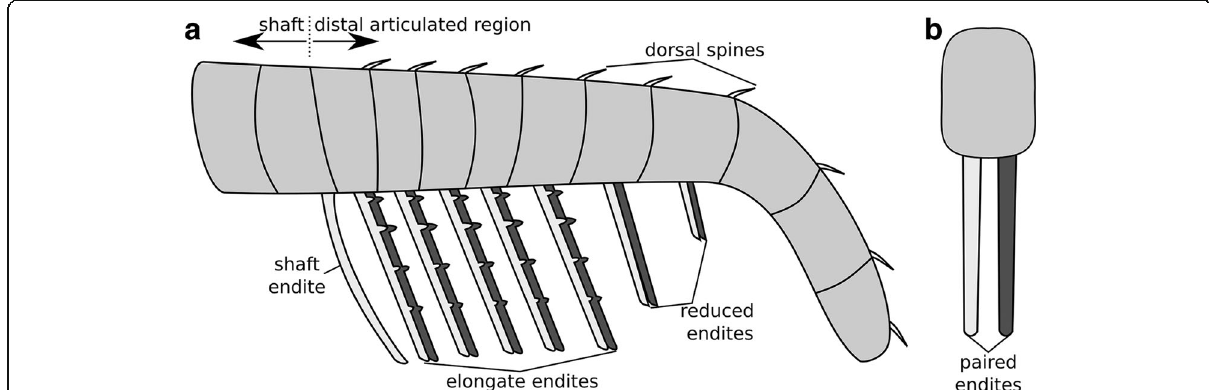
Fig. 6 Reconstruction of Ursulinacaris grallae frontal appendage, with distal podomeres unflexed. a lateral view. b cross-sectional